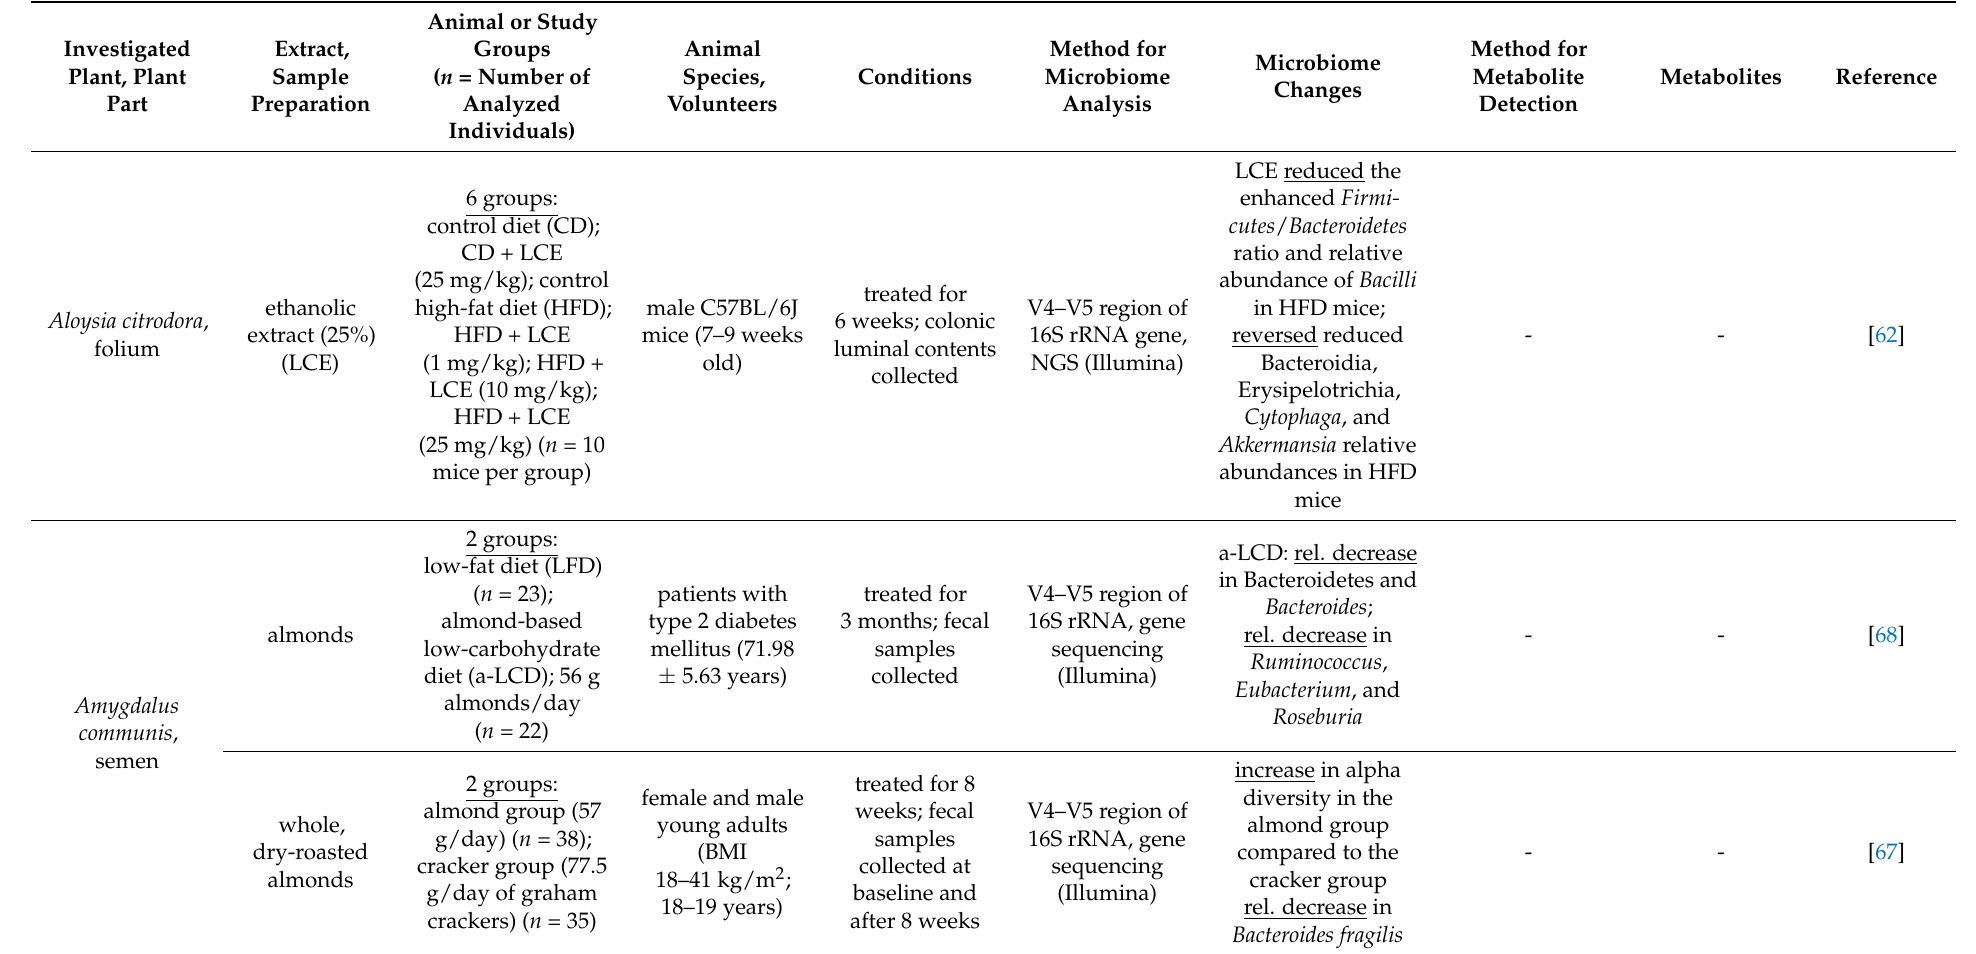
Table 3. In vivo studies of herb–gut microbiome interactions of medicinal plants used for mental health performed in experimental animals or human